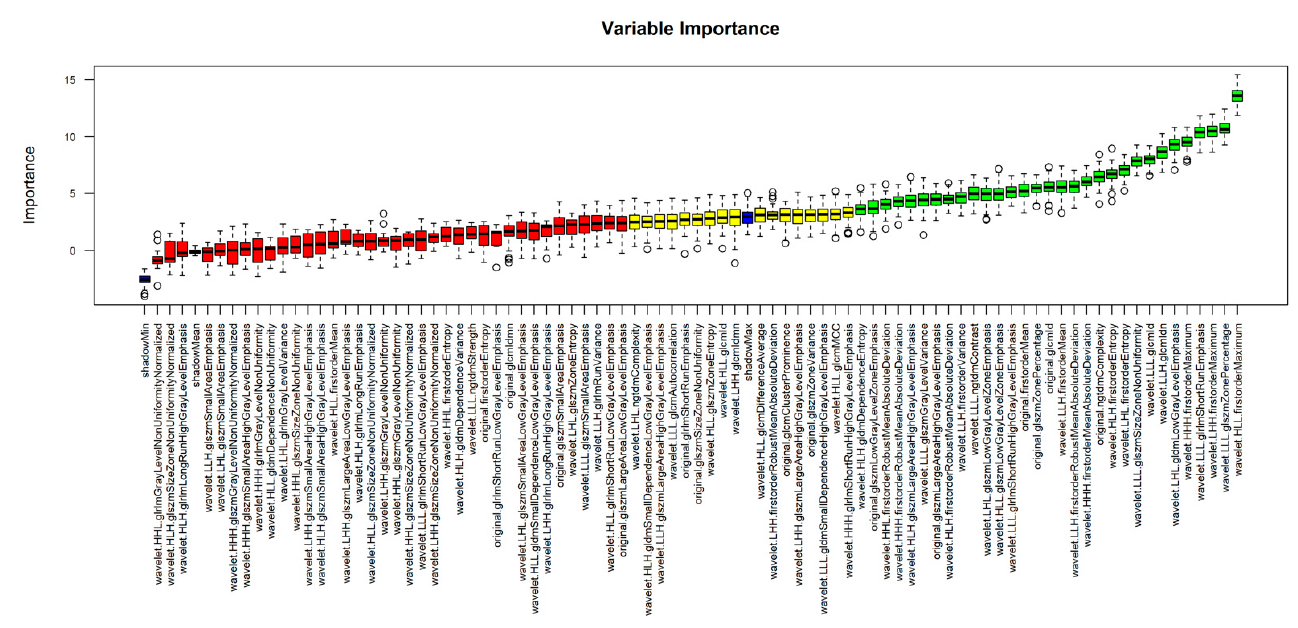
Figure 3. Identification of important features with the use of Boruta feature selection. Following collinearity correction and scaling, Boruta was applied as an artificial intelligence algorithm to select relevant features for unbiased development of machine learning classifiers. The Z-score boxplot presents rejected (red), tentative (yellow) and accepted (green) features. p < 0.01 was used as a cutoff for the selection of accepted features. Blue boxes represent Z-scores of shadow features acting as internal controls for the selection of important variables. Subsequent machine learning was performed using accepted (green) features.